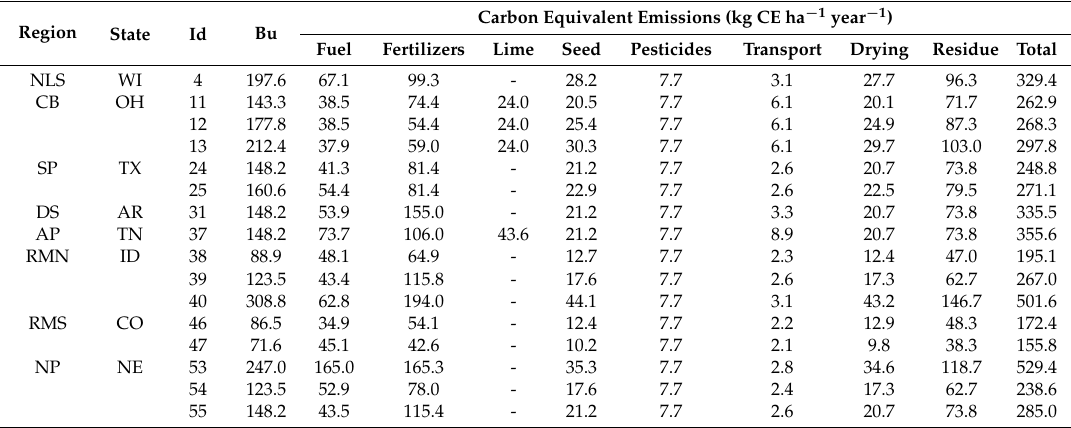
Table A6. Carbon equivalent emissions for wheat systems in the United States. Region